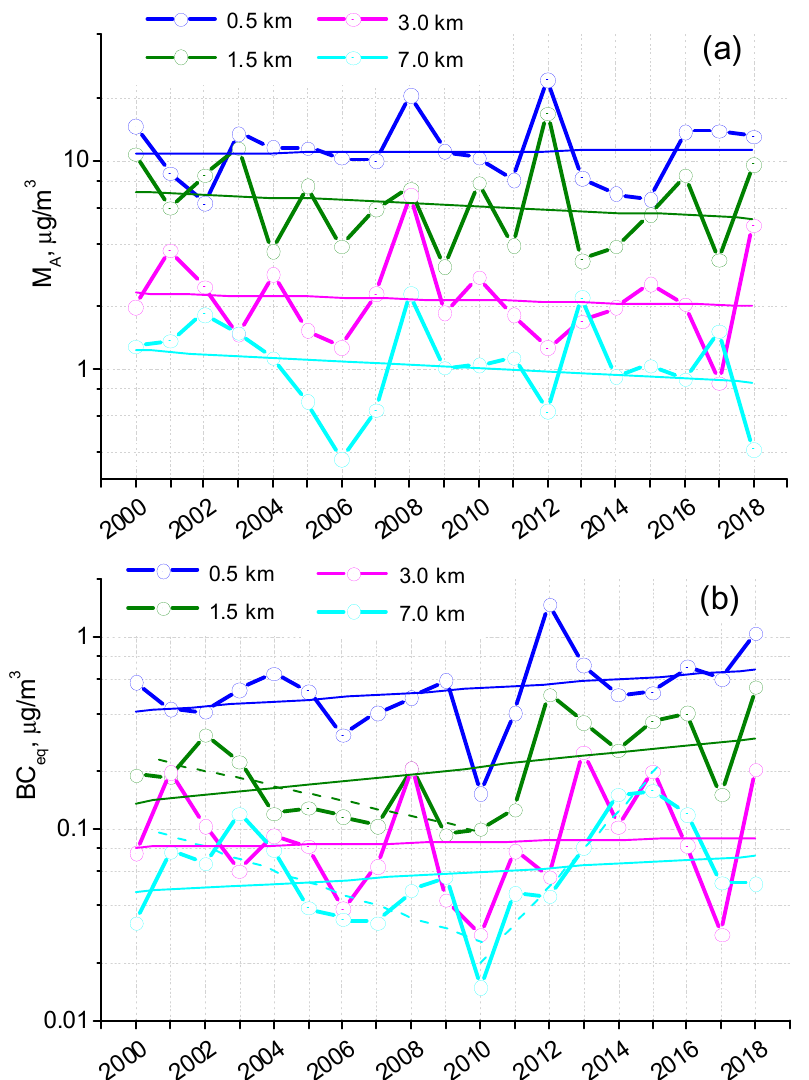
Figure 11. Multiyear behaviors of annual average concentrations of ( a ) aerosol and ( b ) black carbon at different altitudes in clear-sky troposphere (Zavyalovo village) in 2000–2018. Solid lines show trends in 2000–2018, and dashed lines show BC eq trends in 2001–2010 and 2011–2015. Table 4. Trend (% per year) concentrations of M A , BC eq , and their errors and significance ( p -value), given in parentheses, at different altitudes in